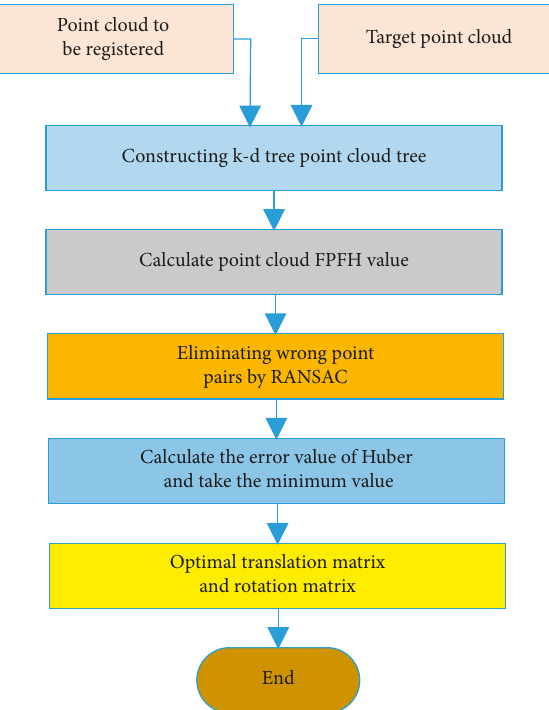
Figure 3: Rough registration